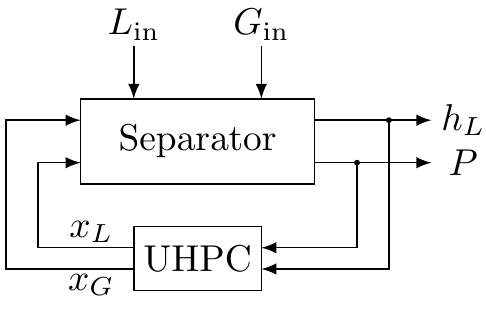
Figure 3. Control loop for the oil separator with